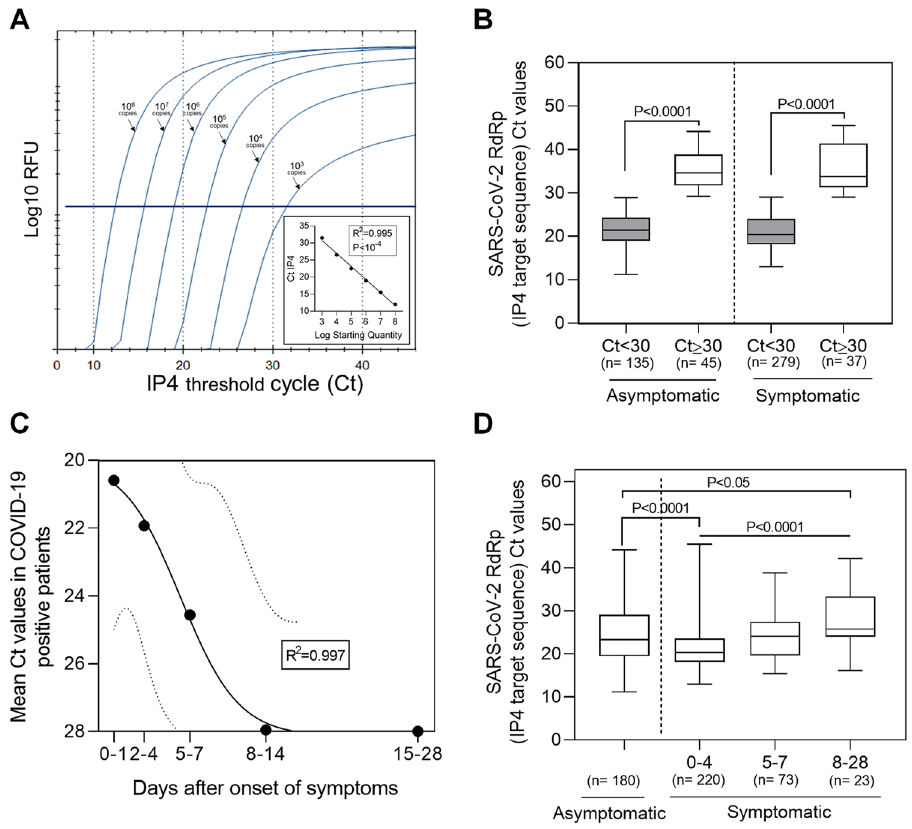
Figure 1. Distribution of viral loads estimated by SARS-CoV-2 RT-qPCR according to the presence of clinical symptoms and to the delay between the respiratory sample and the onset of symptoms in outpatients. ( A ) Cycle threshold (Ct) values of RNA dependent RNA polymerase (RdRp) target sequence (IP4) on SARS-CoV-2 RNA genome after serial ten-fold dilutions of synthetic SARS-CoV-2 RNA transcripts ranging from 10 8 to 10 3 copies. These positive controls for used for real-time RT-qPCR were synthetic RNA derived from cDNA plasmid of the BetaCoV_Wuhan_WIV04_2019 strain (EPI_ISL_402124). A significate correlation (R 2 = 0.995, P < 10 –4 ) was displayed between Ct values of IP4 sequence of SARS-CoV-2 and log 10 starting quantity of SARS- CoV-2 RNA copies: this curve was used in each RT-qPCR serial analyses to validate our quantitative assay and to check that obtained Ct values inversely reflected viral load levels. ( B ) and ( D ) Boxes denote interquartile ranges, and horizontal bars denote median CT values of IP4 sequence among patients asymptomatic or symptomatic. Whiskers IP4 Ct values denote the maximum and minimum values below or above the median. ( B ) The shaded boxes indicate IP4 Ct values < 30 among asymptomatic (n = 135) or symptomatic (n = 279) patients whereas white boxes indicate IP4 Ct values ≥ 30 among asymptomatic (n = 45) or symptomatic (n = 37) patients ( P < 0.0001). ( C ) Correlation of means Ct values in COVID-19 positive patients and days after onset of symptoms. The outer dotted lines are 95% confidence interval. Data represent standard curve to regression sigmoidal with a goodness of fit (R 2 = 0.997). ( D ) Comparison of IP4 Ct values between asymptomatic outpatients (n = 180) and symptomatic sub-groups of outpatients stratified according to the delay between the respiratory sample and the onset of symptoms; 0–4 (n = 220), 5–7 (n = 73) and 8–28 (n = 23) days after the apparition of clinical symptoms ( P < 0.0001). Data represent the median ± SD. *: P < 0.05; according to ANOVA test. Data represent the median ± SD. *: P < 0.05; ****: P < 0.0001; according to ANOVA